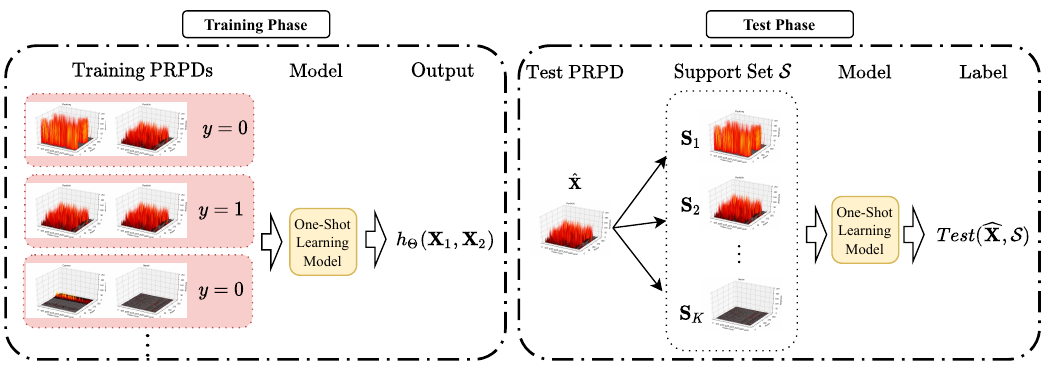
Figure 7. Architecture of the proposed one-shot learning